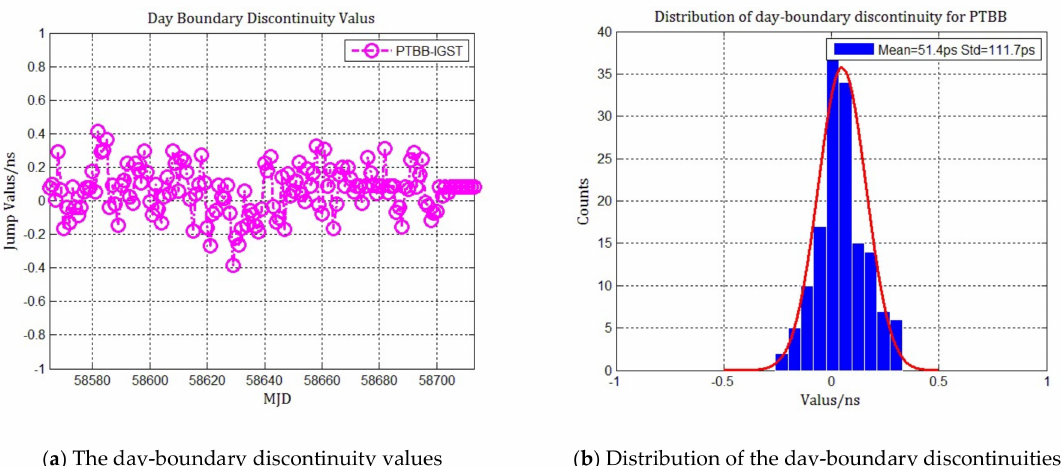
Figure 1. Statistics of the day boundary discontinuities and distribution in combined multi-GNSS PPP for PTBB. ( a ) The day-boundary discontinuity values in nanoseconds; ( b ) The distribution of the day-boundary discontinuities compared to Gaussian